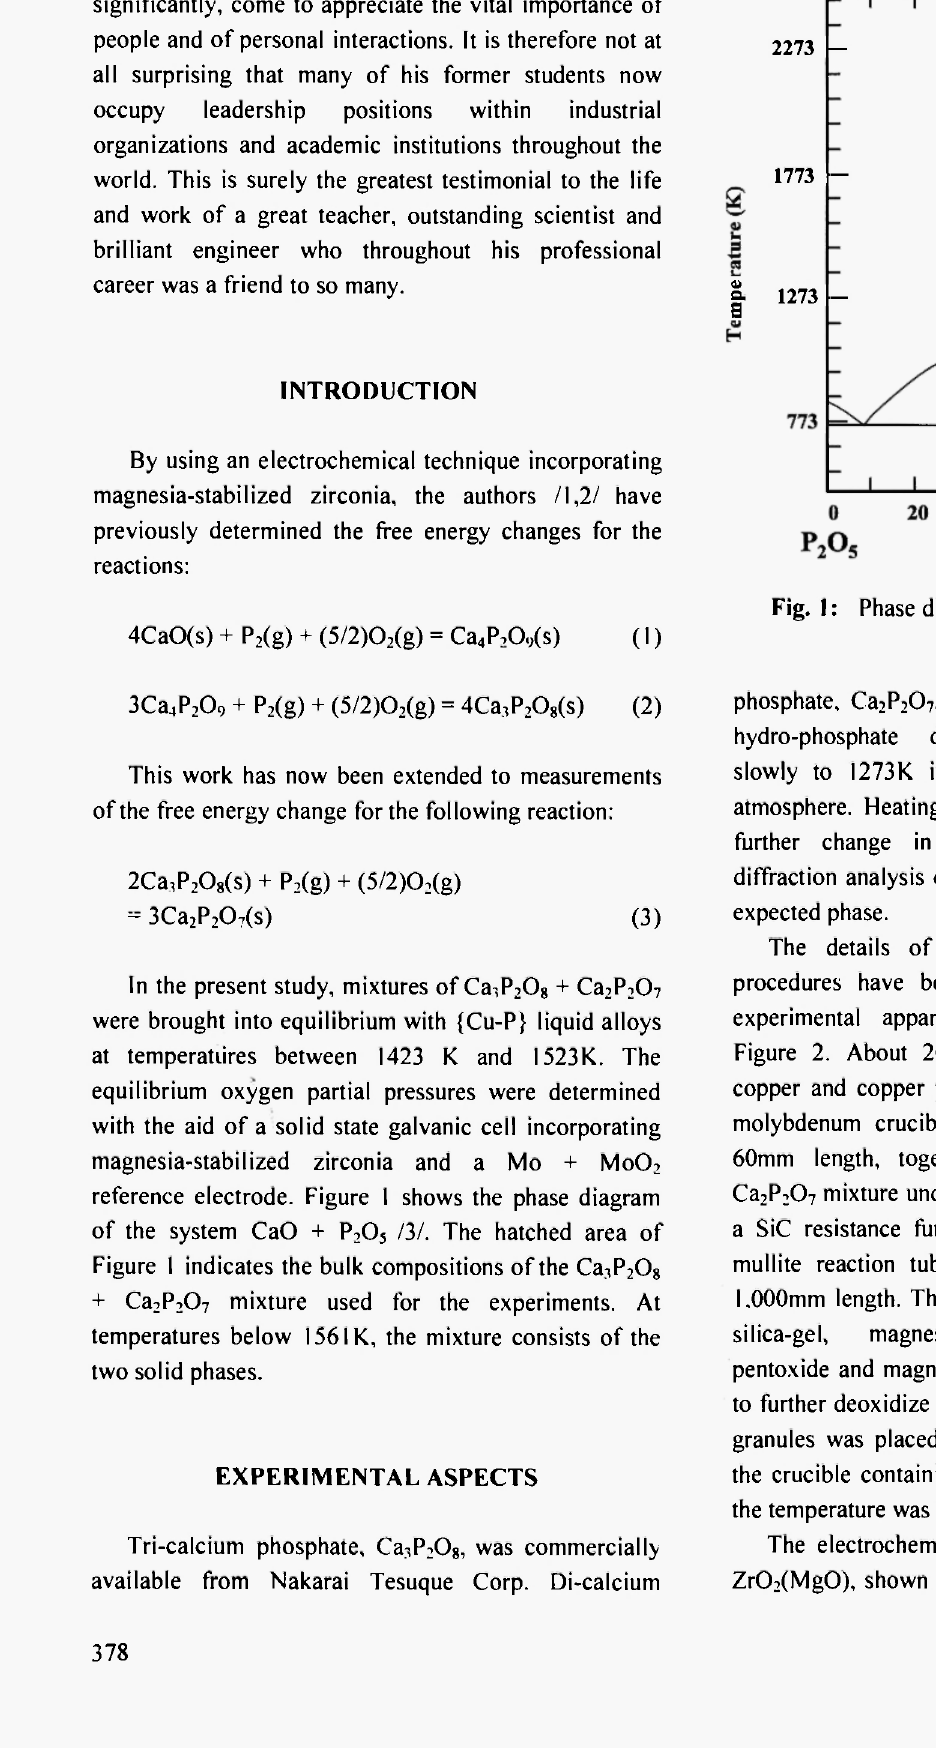
Fig. 1 : Phase diagram of the system CaO - P 2 0 5 .